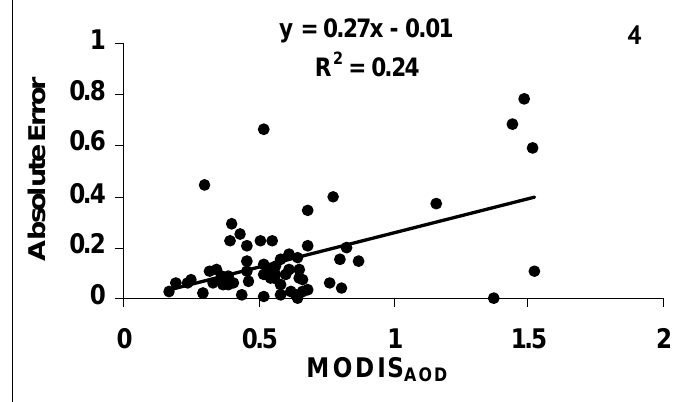
Fig. 4. Scatter plot of the absolute error in τ aMODIS retrievalvs τ aMODIS over Kanpur.